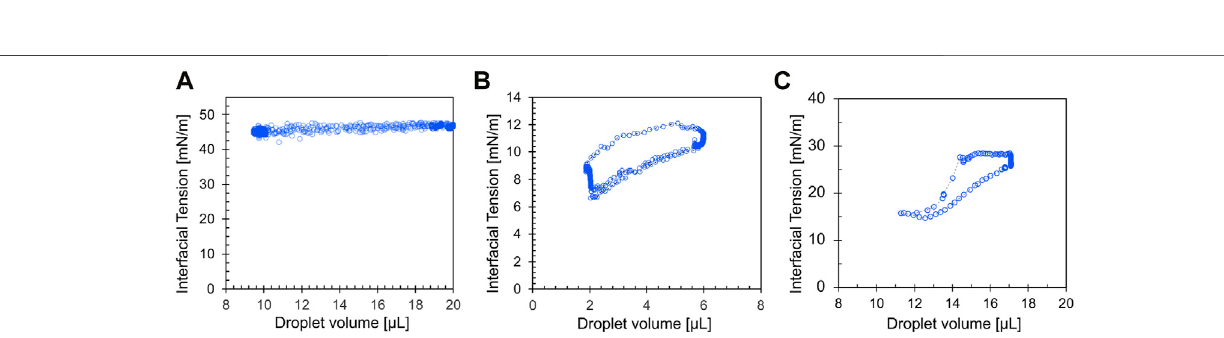
Frontiers in Mechanical Engineering |